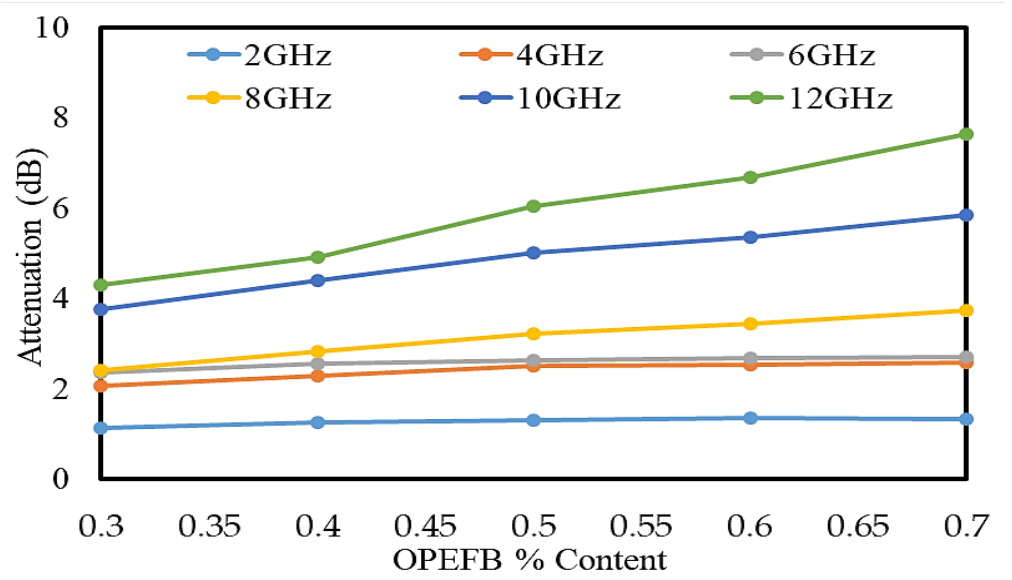
Figure 12. Calculated attenuation of OPEFB/PLA composites at different OPEFB wt% filler.